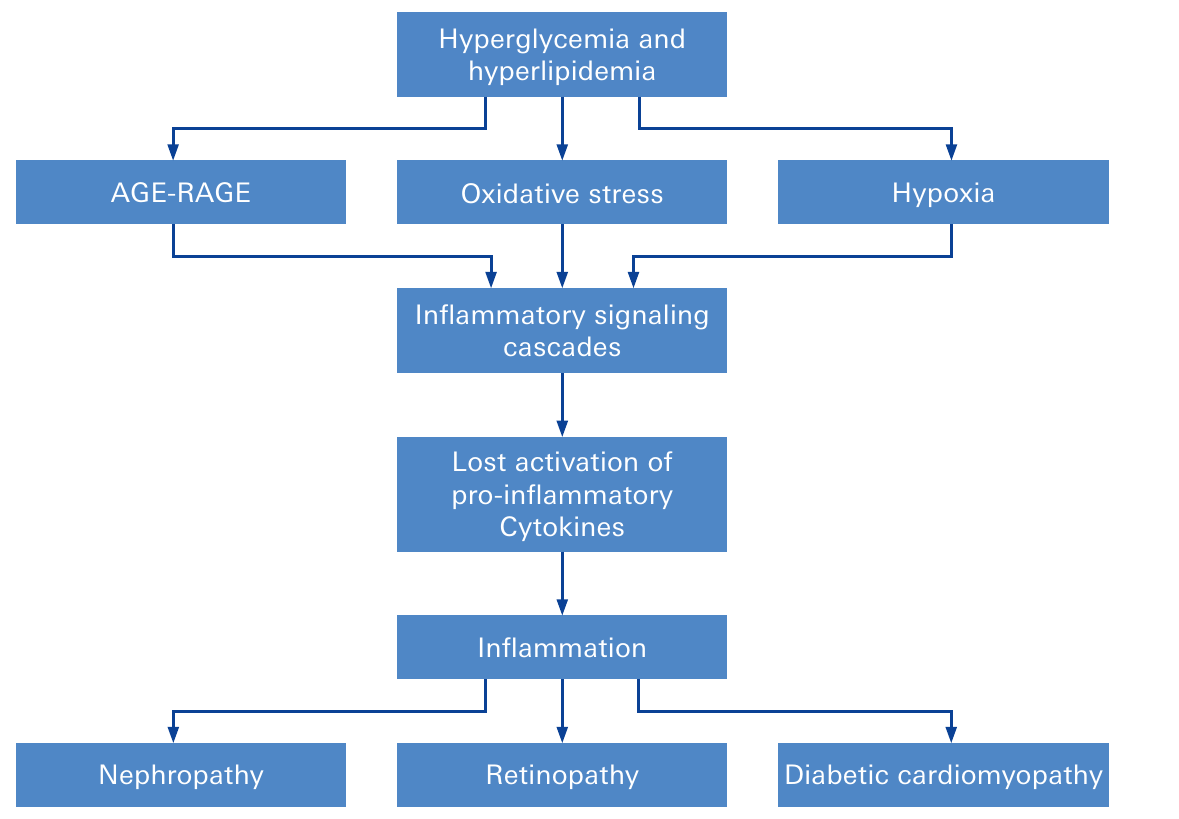
Figure 3. Potential mechanisms for diabetes-associated vascular abnormalities (DAVA). Common pathogenic mechanism as the production of advanced glycation end products (AGE), abnormal activation of signaling cascades (such as protein kinase C [PKC]), elevated production of reactive oxygen species (ROS, oxygen-containing molecules that can interact with other biomolecules and result in damage) [61], and abnormal stimulation of hemodynamic regulation systems (such as the renin-angiotensin system